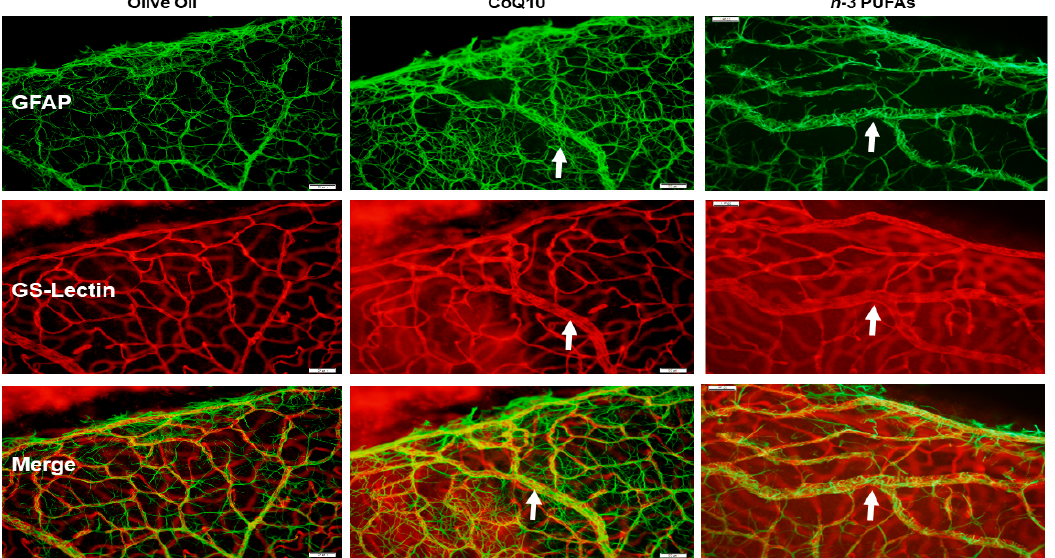
Figure 6. Representative images of retinal flatmounts from 21-day-old rat exposed to 50/12% O 2 IH. Astrocytes and Müller cells were stained for GFAP immunoreactivity (green), and retinal vasculature was stained with isolectin B4, which is a biomarker for endothelial cells (red). Merged images are presented in the bottom panel. Animals were supplemented with olive oil ( left panels ), CoQ10 ( middle panels ), or n -3 PUFAs ( right panels ). Images are 10× magnification and the scale bar is 100 µM.